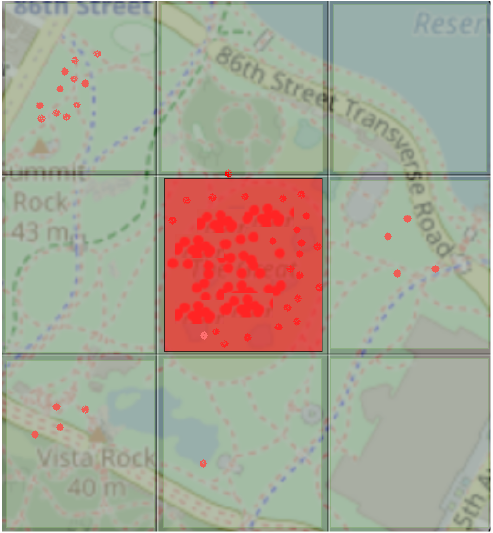
Figure 12. A simulation example at time t1 of the proposed